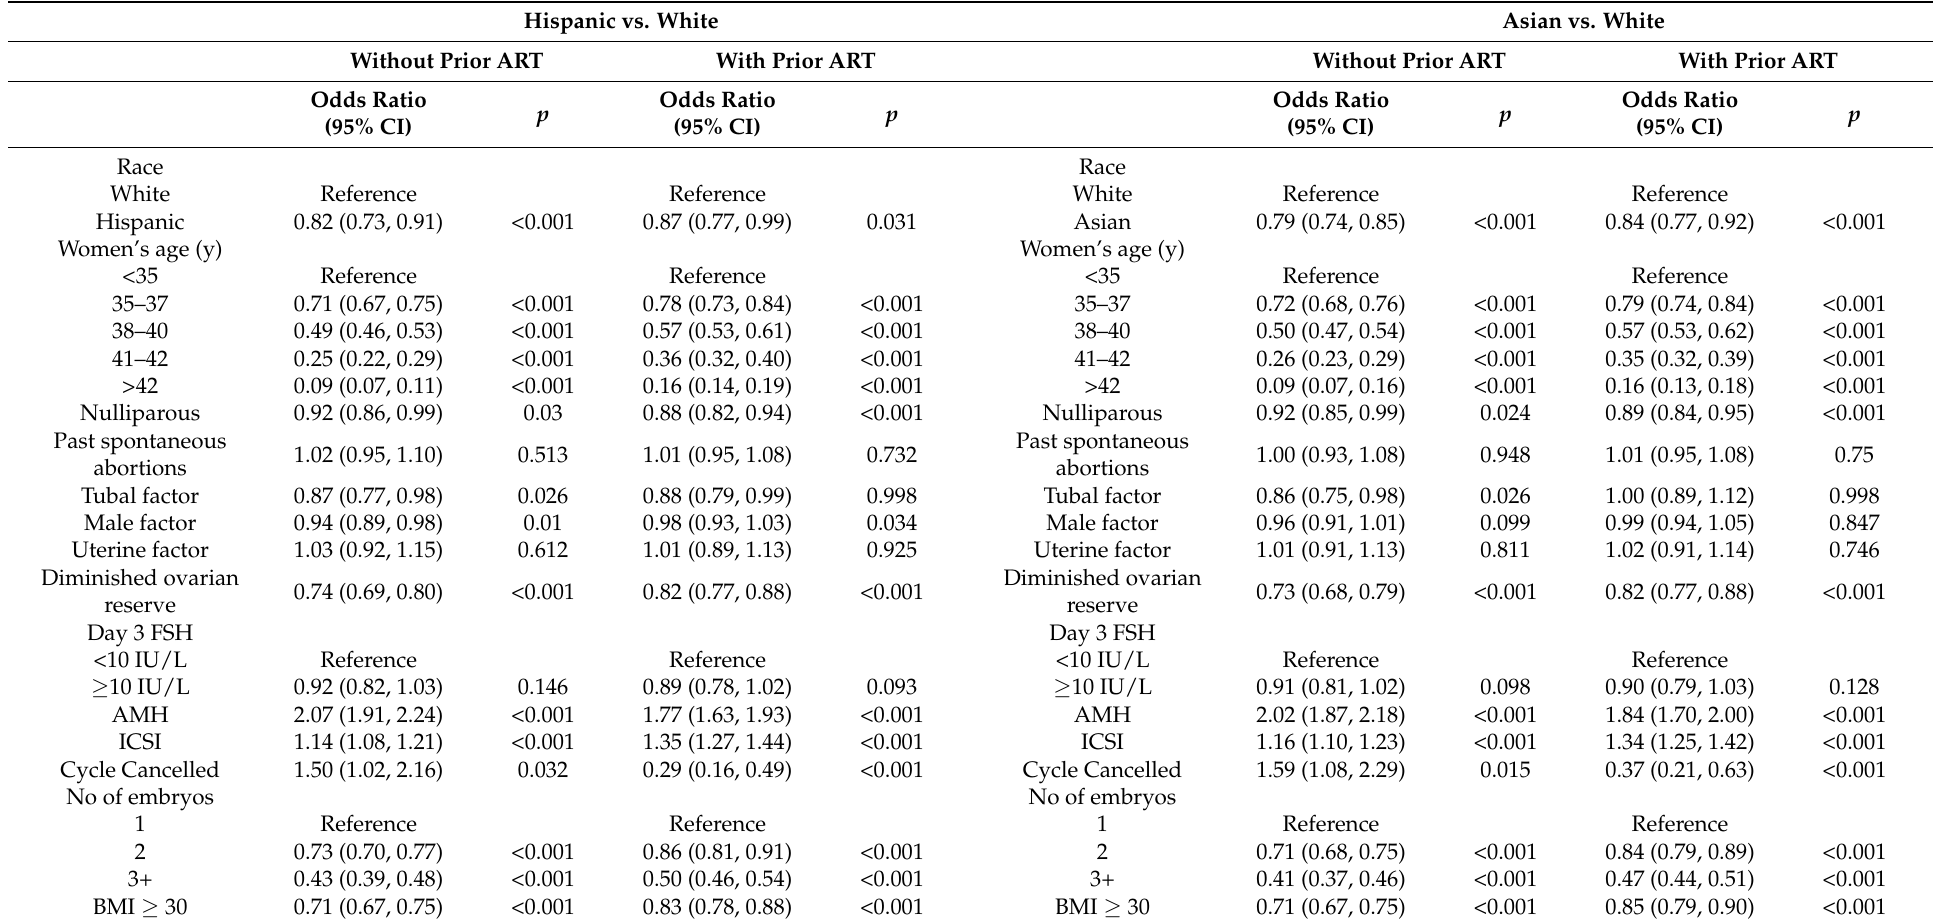
Table 4. Cumulative live birth rate for primary transfer (fresh or thawed FET) in Hispanic, Asian, and WNH women for 2014–2015. Hispanic vs. White Asian vs. White Without Prior ART With Prior ART Without Prior ART With Prior